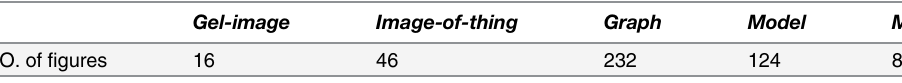
Table 5. Statistics of biomedical figures with five different types.